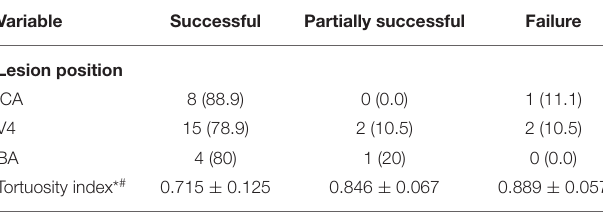
TABLE 4 | Success and tortuosity index of OCT examination.